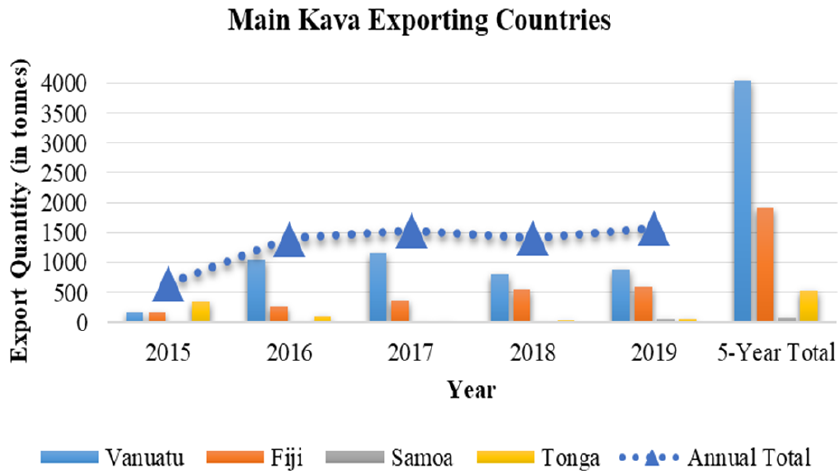
Figure 2. Kava exports from the main exporting countries between 2015 and 2019.